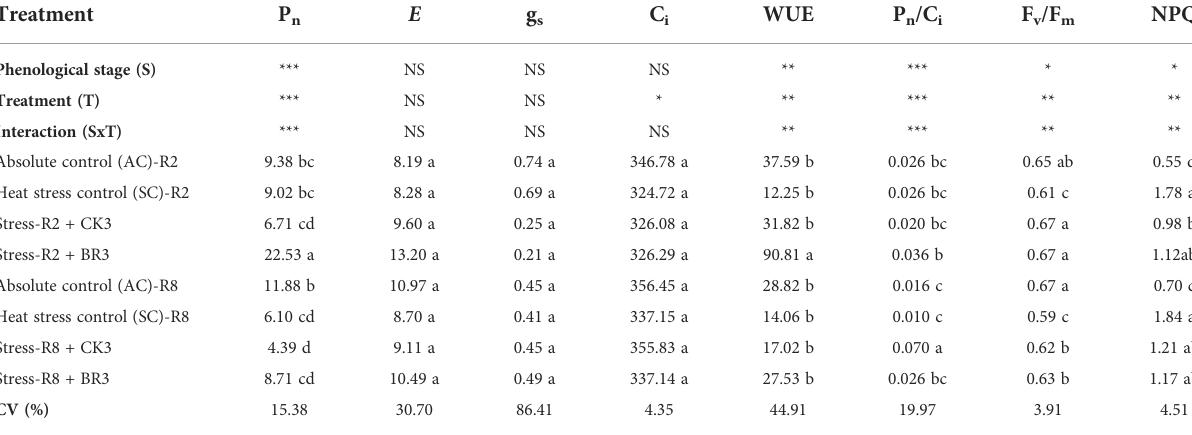
TABLE 5 Effect of the applications of two growth regulators (cytokinins (CK) or brassinosteroids (BR)) on the photosynthetic variables of rice plants of genotype Federarroz 2000 subjected to combined heat stress (40°C day/30°C night) at R2 (88 DAE) or R8 (108 DAE).